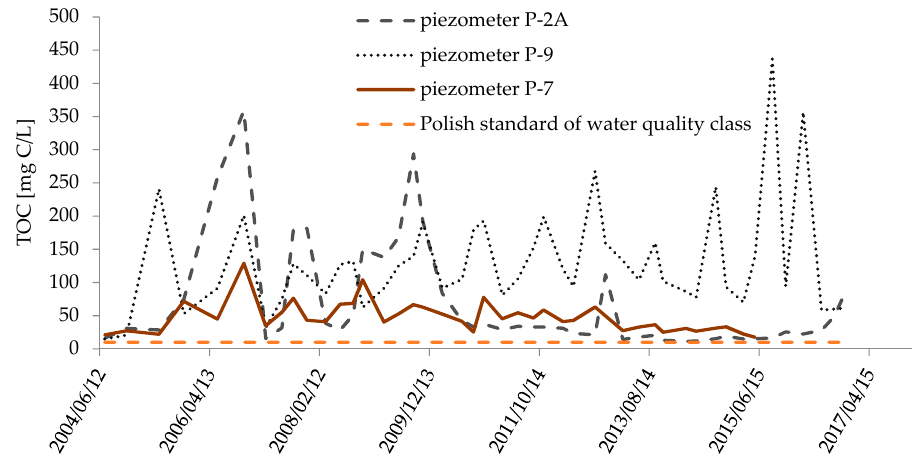
Figure 12. Temporal changes of the TOC level in piezometers located in the landfill area.